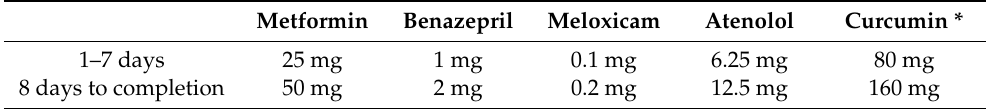
Table 1. Treatments used for multimodal renin-angiotensin system inhibition. * Due to variability in the natural product used to administer curcumin, the full dosage is expected to be in the range of 160–180